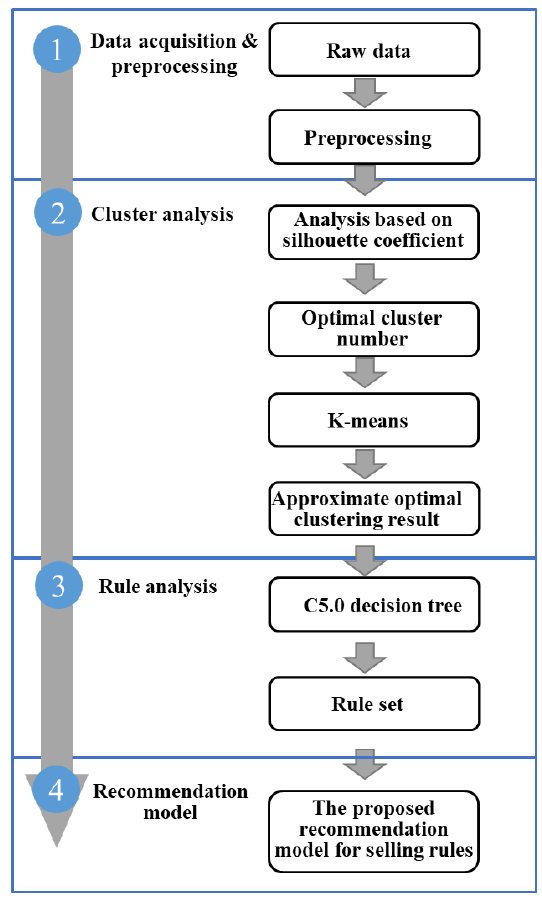
Figure 1. Research framework.